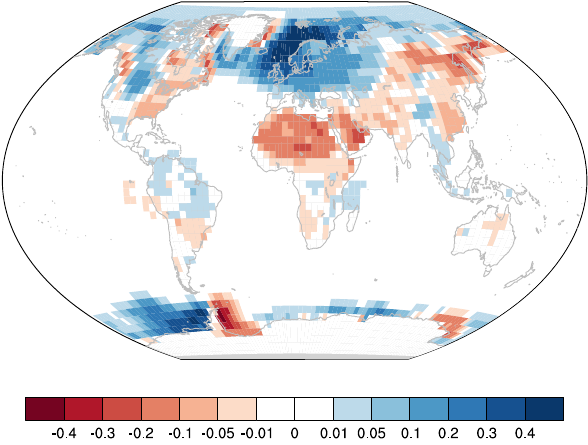
Figure 12. Differences in surface albedo